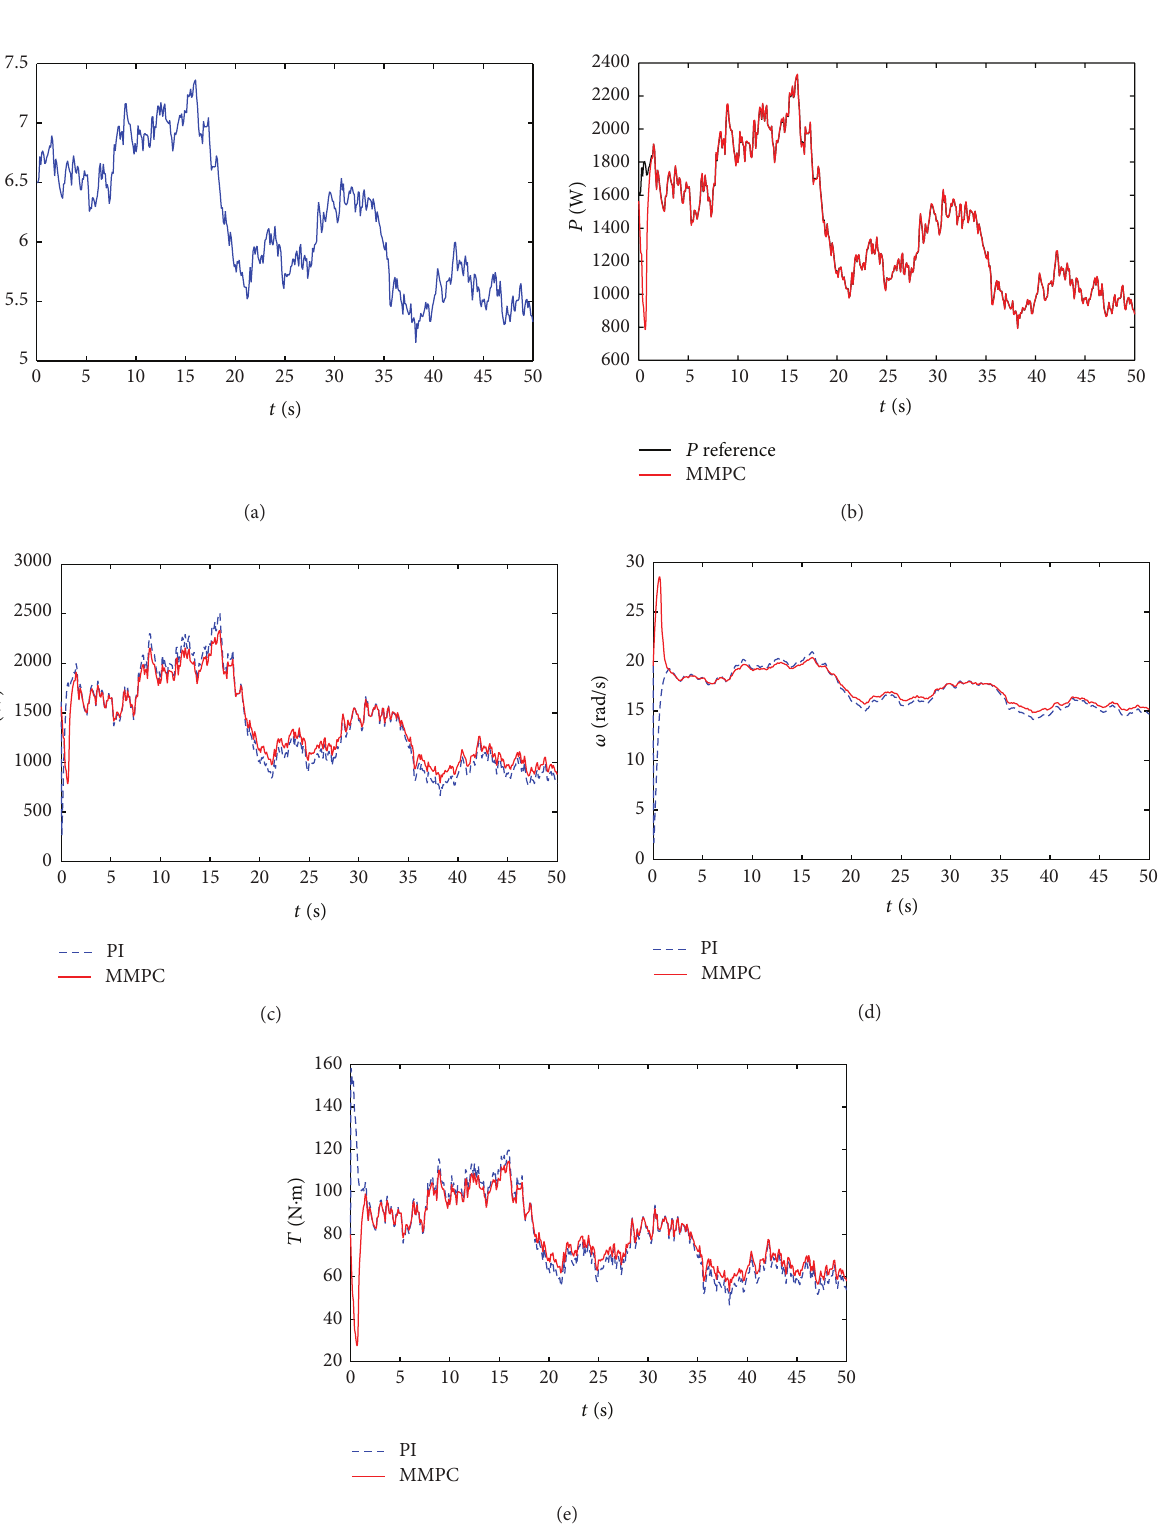
Figure 7: (a) Wind speed. (b) Generator power. (c) Generator power. (d) Turbine rotational speed. (e) Generator